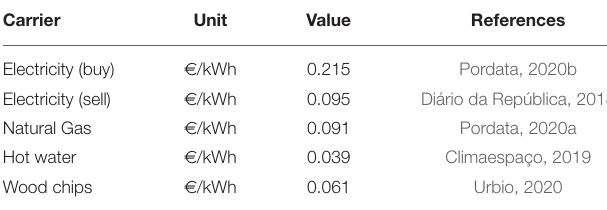
TABLE 1 | Energy carrier prices.